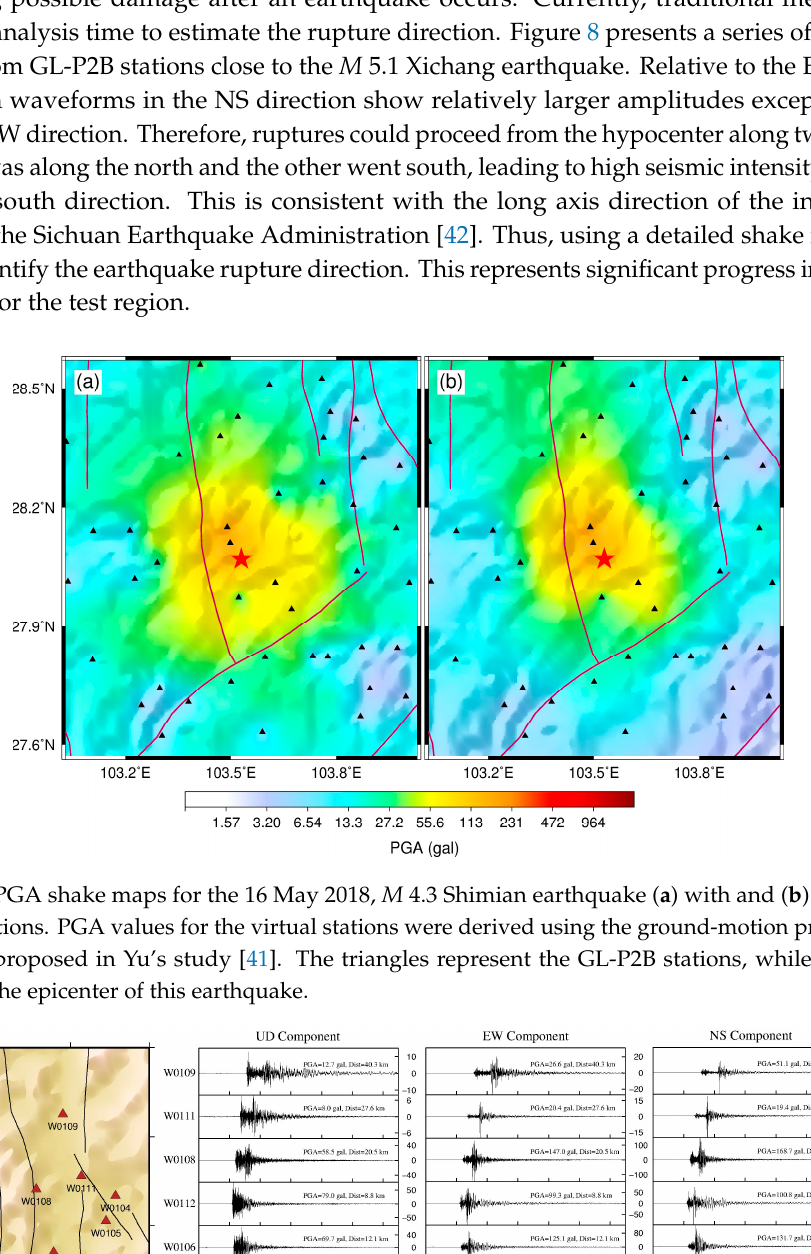
Figure 8. A series of acceleration waveforms recorded by GL-P2B sensor network during the 31 October 2018, M 5.1 Xichang earthquake. These plots show the data quality of the network for up– down (UD), east–west (EW), and north–south (NS) components.